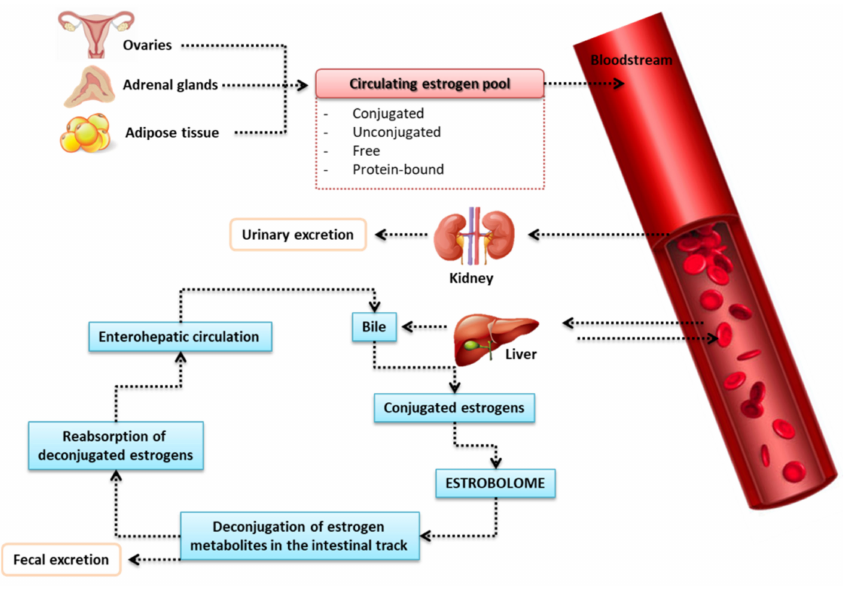
Figure 5. Metabolic changes of estrogen in the human body